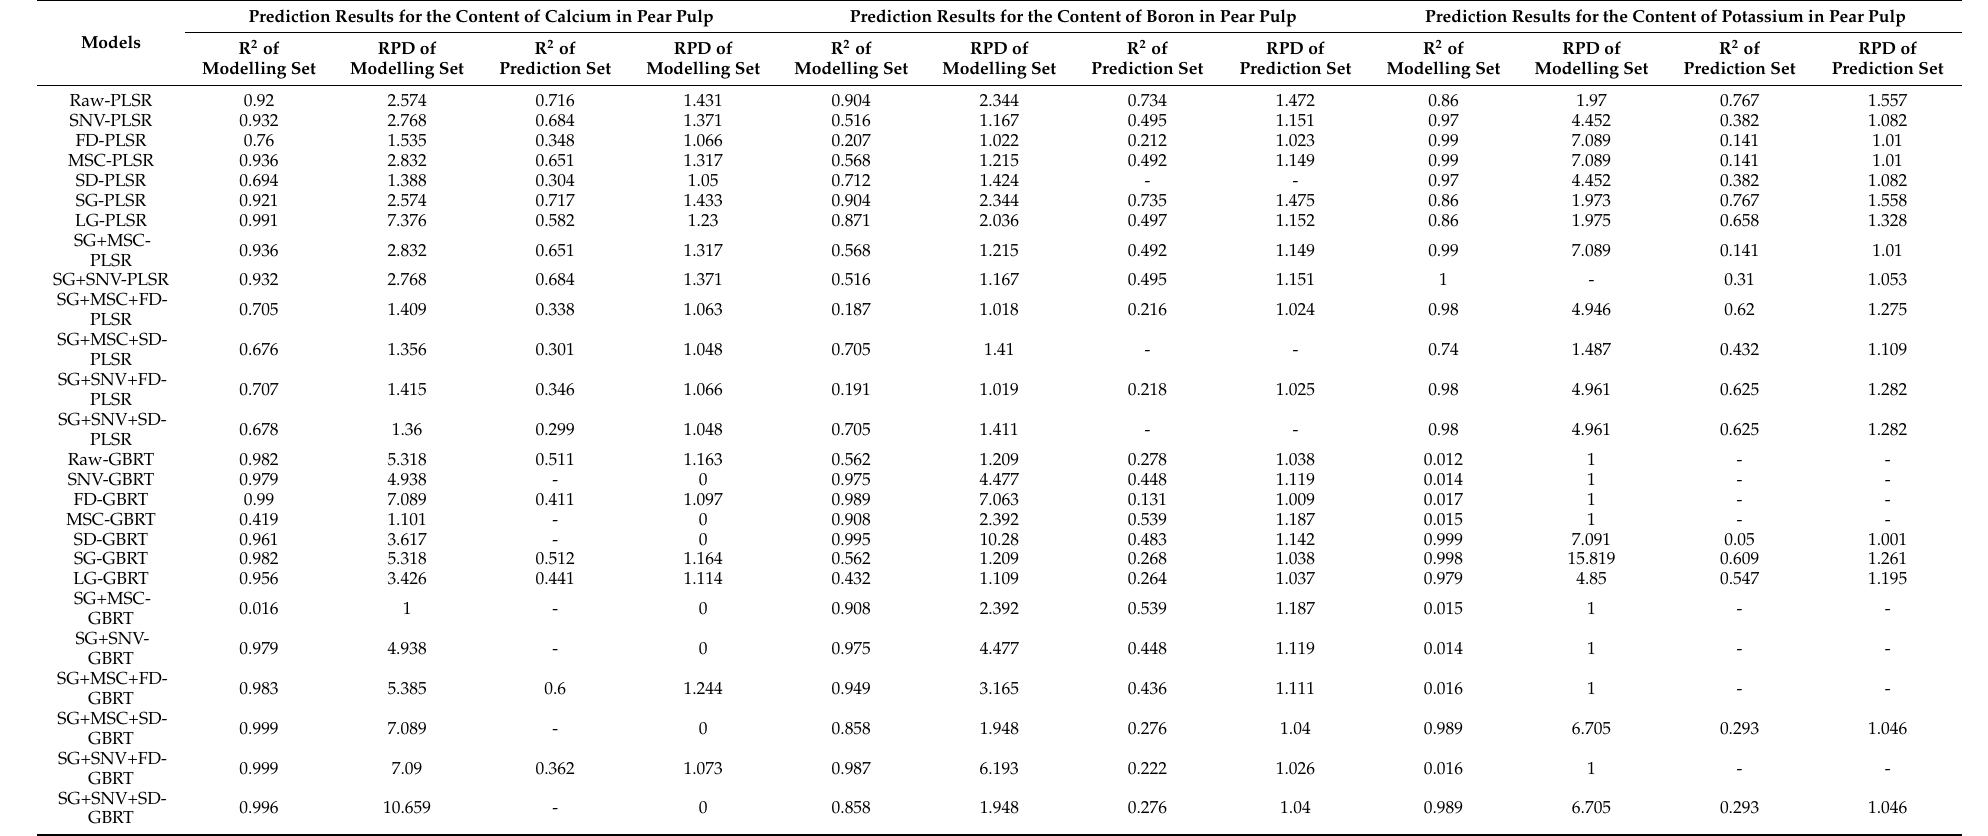
Table 2. Comparison of the prediction and modelling sets for the content of calcium, boron and potassium in pear pulp based on full-wave band.